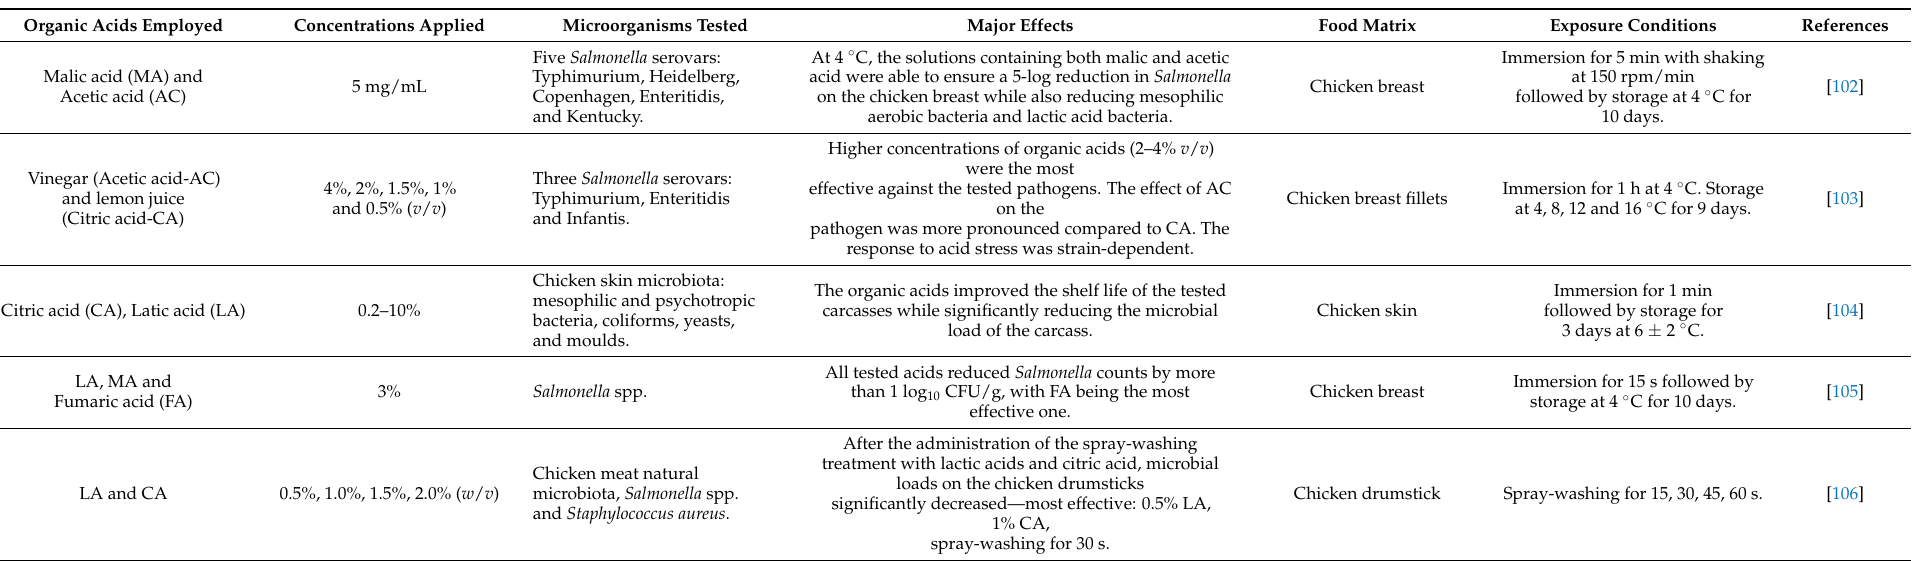
Table 3. Studies evaluating the antimicrobial activity of organic